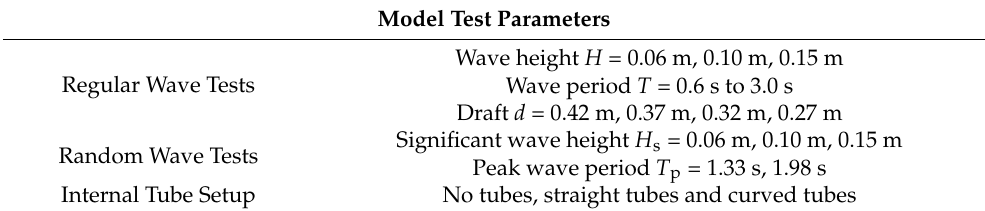
Table 2. Model Test